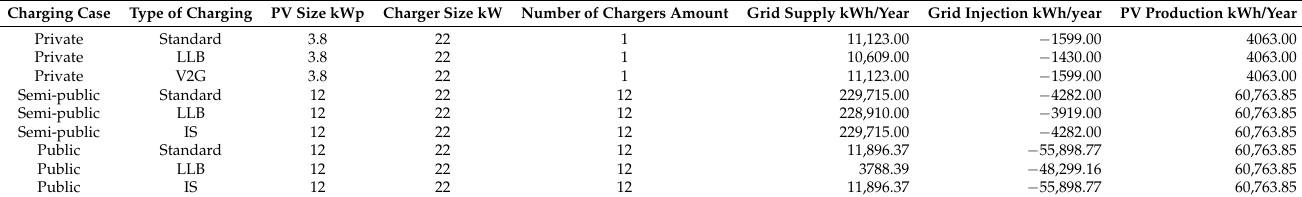
Table 3. Charging location description of different charging cases (source: estimations/own compilation and output of internal calculations performing energy balance with an energy cost minimization